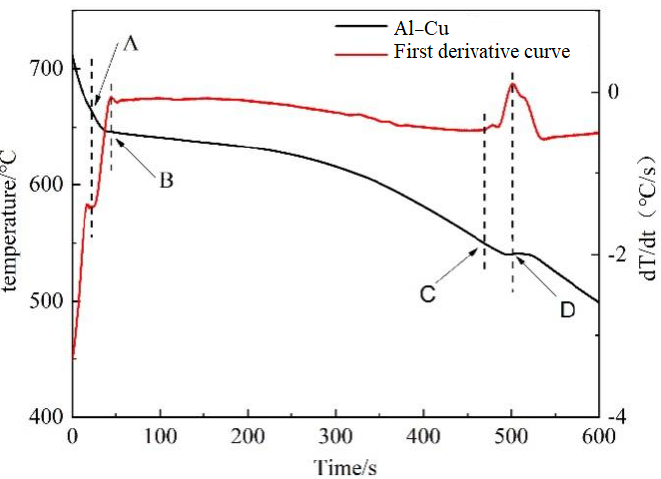
Figure 3. Typical ZL205 alloy solidification curve and first-order differential curve.